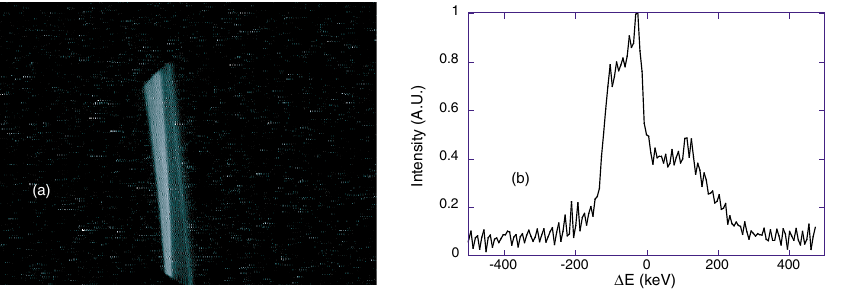
FIG. 25. (Color) (a) Image of the compressed beam at the spectrometer. (b) Lineout of the image in (a). The relative, rms energy spread is roughly 0.5%.